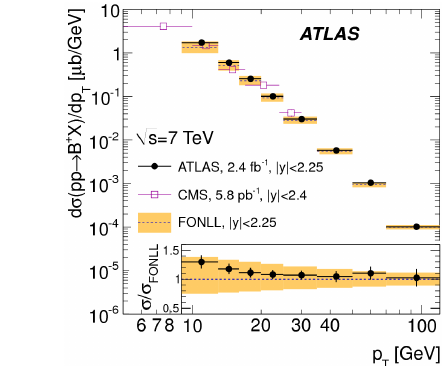
TeV data [11]. The di ff erential cross section in the kinematic range 9 GeV < p T < 120 GeV and | y | <